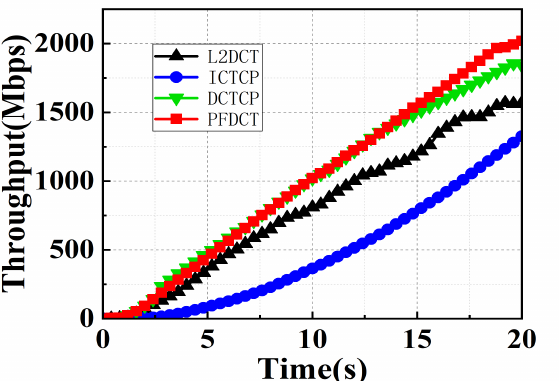
Figure 10. Throughput comparison of multiple schemes in large-scale